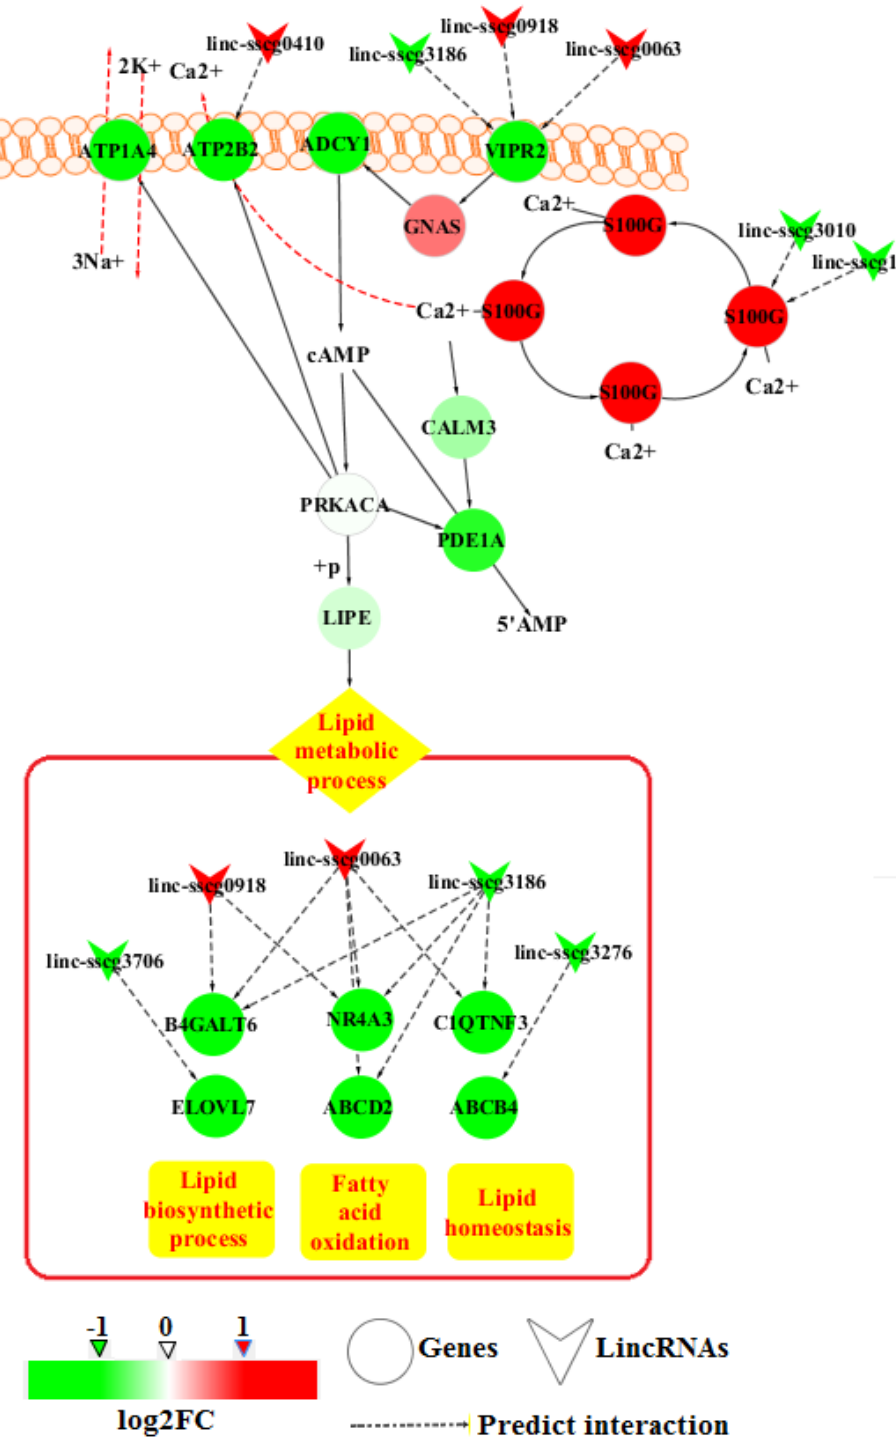
Figure 5. Potential pathways of the annotated DE genes and lincRNAs in the adipose tissues of high- and low-FE pigs. Red and pink colors indicate up-regulation in high-FE pigs (red, log2FC > 1; pink, 0 < log2FC < 1), while neon green and light green indicate down-regulation in high-FE pigs (neon green, log2FC < − 1; light green, − 1 < log2FC <